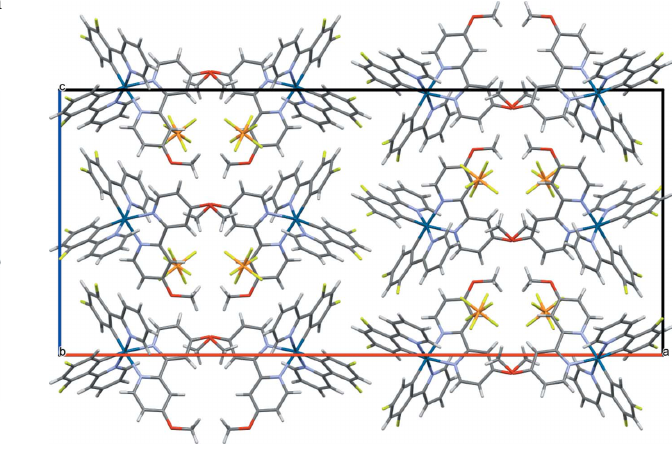
Figure 3 Packing diagram of the title compound viewed along [010].